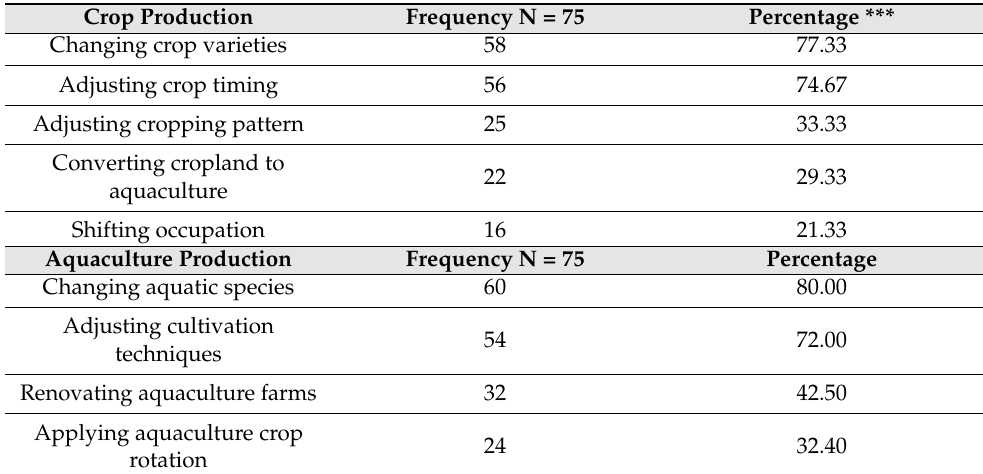
Table 10. Farmers’ responses to climate change in crop and aquaculture